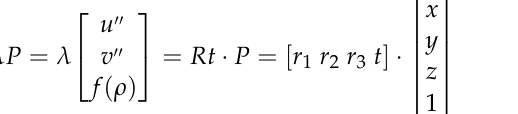
4 of 18 Figure 2. Fish-eye camera model and coordinate system. ( a ) Camera model. ( b ) Imaging plane coordinate system. ( c ) Image coordinate system. In this model, the projection system from world coordinates to image plane coordinates is a non-linear projection function containing camera distortion parameters.